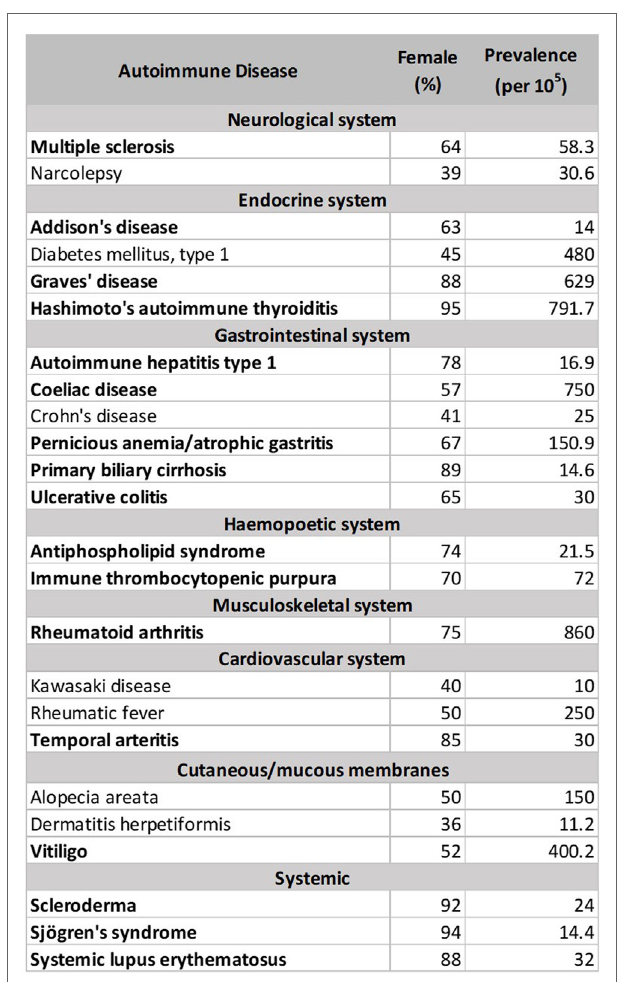
FiGURe 1 | List of Autoimmune Diseases (ADs) with prevalence ≥ 1 per 10,000 people.